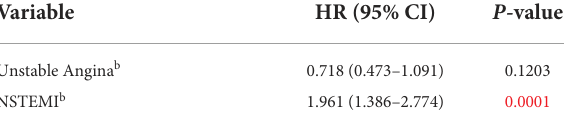
TABLE 2 Univariate Cox model (on overall survival time); with 346 who performed BMS or DES (147 deaths).